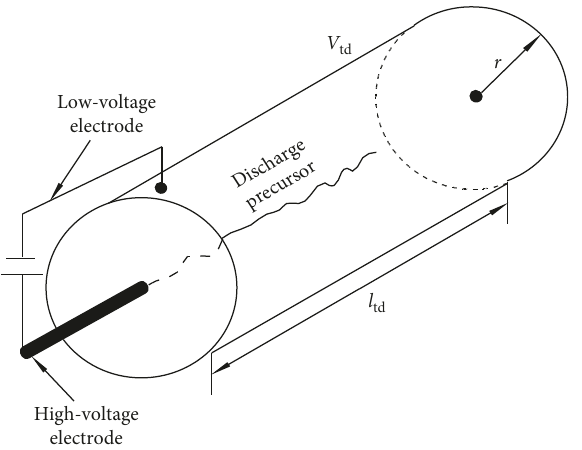
Figure 4: Cylindrical plasma channel